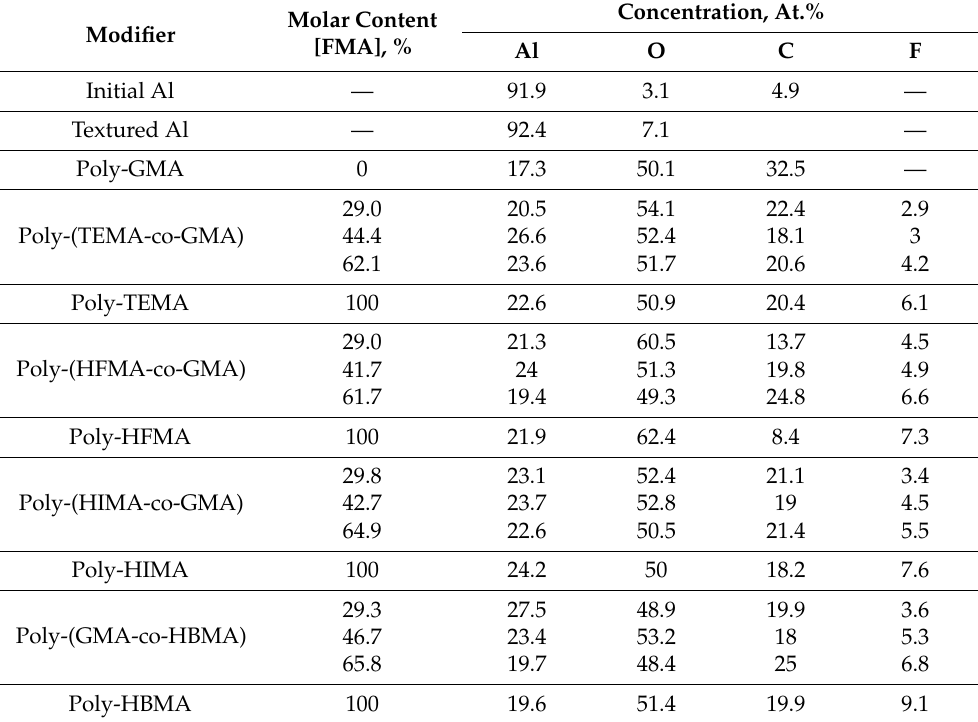
Table 3. Chemical composition of the initial and modified aluminum surface (using the EDS method).